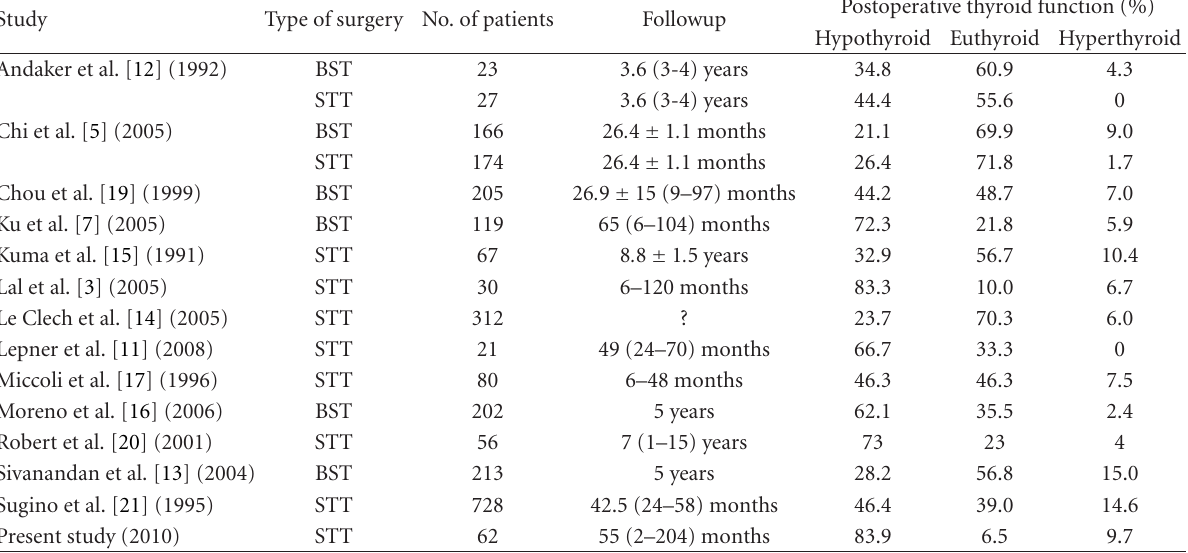
Table 2: Thyroid function after subtotal thyroidectomy for Graves’